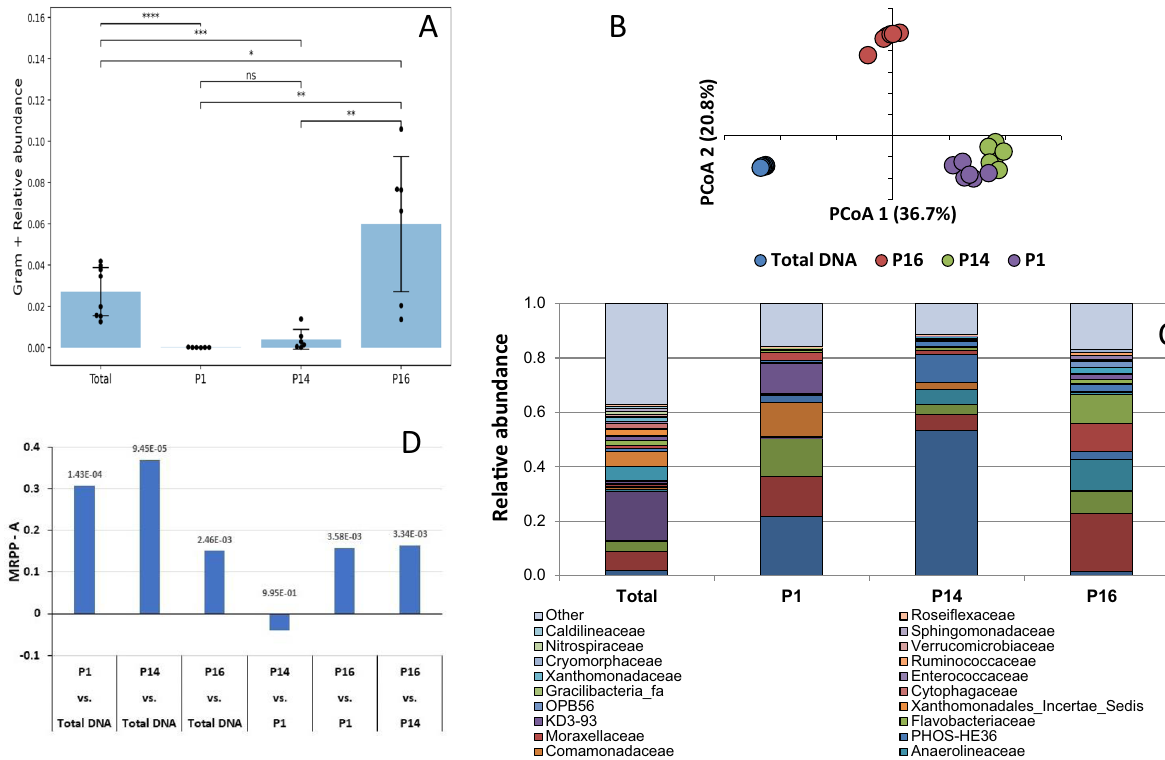
Fig. 8 FACS and sorted populations sequencing analyses. Gates P1, 14, and gate P16 de fi ne regions containing events positive and negative for the BDE525 fl uorescent signal, respectively. A Relative abundance of gram-positive bacteria in the P1, P14, and P16 samples, and in total bacteria., determined from 16S rRNA gene community sequencing. Relative abundance was calculated by summing the abundance of reads assigned to the Firmicutes and Actinobacteria phyla, which contain the vast majority of gram-positive bacterial species divided by the total read number. Error bars show standard deviation Total DNA: 4 independent samples, in two technical replicates; All three gates were sorted twice, from three independent samples. Dots represent individual measurements. B Principal coordinate analysis of the sorted cells from the different gates. C Community composition analysis of the samples collected from gates P1, P14 and P16. Taxa are represented at the family level. D MRPP comparisons of Bray – Curtis distances between the communities in the sorted gates (P1, P14, P16) and the general community (total DNA). ns: 5.00e-02 < p < = 1.00e + 00; *: 1.00e-02 < p < = 5.00e-02, **: 1.00e-03 < p < = 1.00e-02; ***: 1.00e-04< p < = 1.00e-03; ****: p < = 1.00e-04; no adjustment for multiple